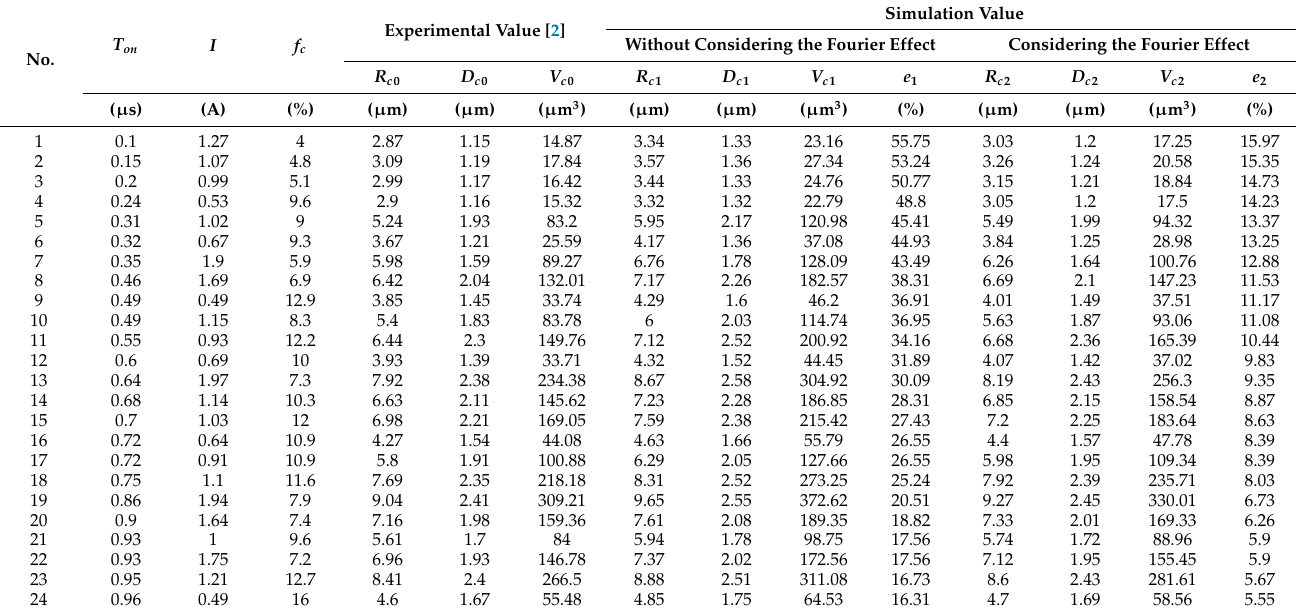
Table 3. The verification of the thermal model in